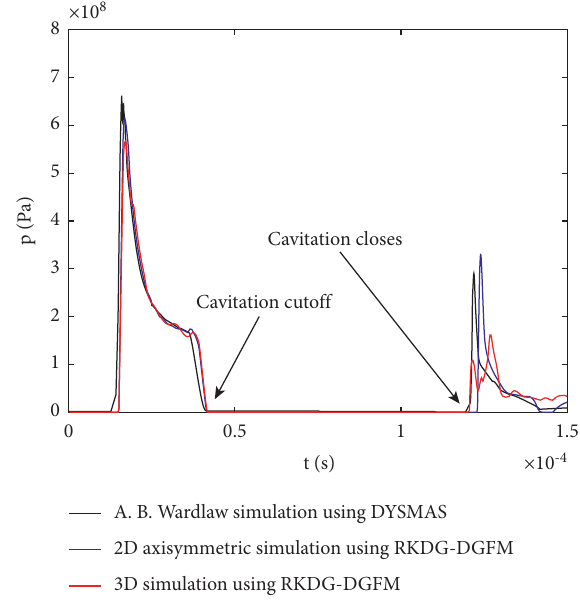
Figure 24: Pressure-time history at the inner center of the rigid